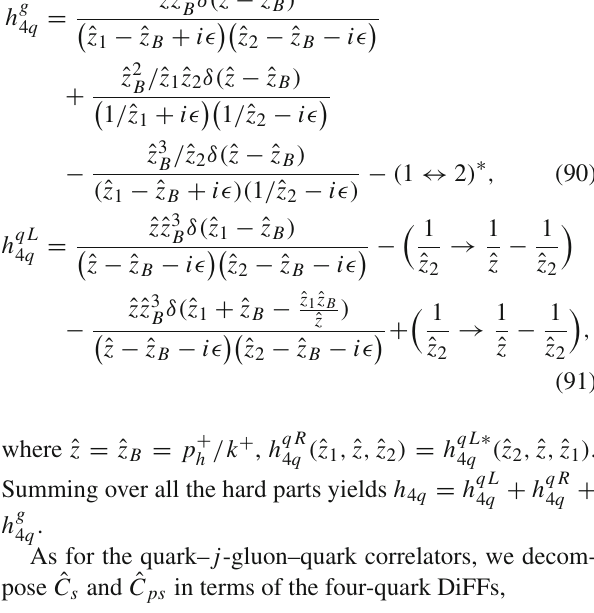
; in ( c ) we have the interchange of k 2 with k (cid:4) 1